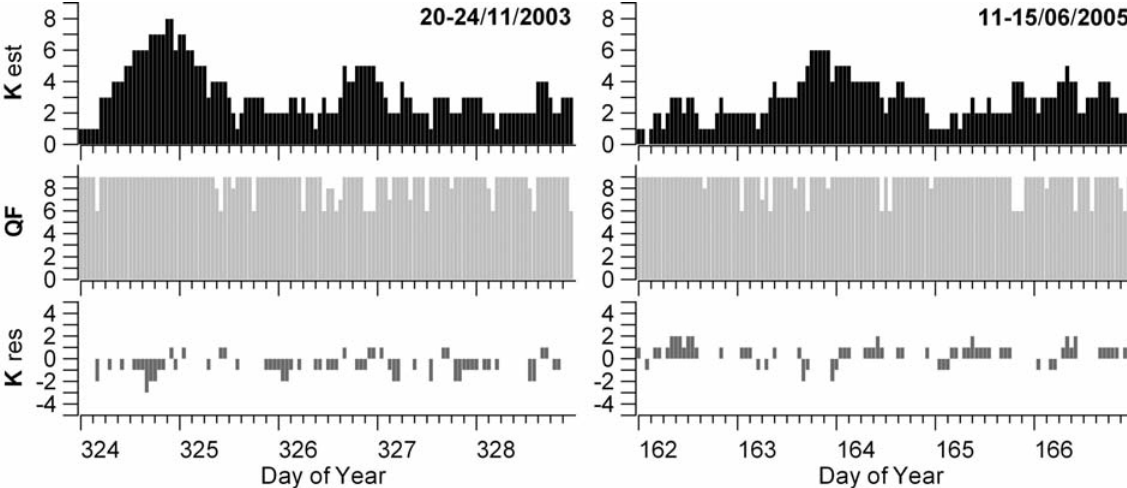
Figure 5. Representative results of the K index nowcast at Dourbes during first-class geomagnetic storm events of November 20-24, 2003 (left panels) and June 11-15, 2005 (right panels). Top panels: nowcast K index (Kest). Middle panels: quality flag (QF). Bottom panels: residual errors (Kres), i.e. the Kest minus